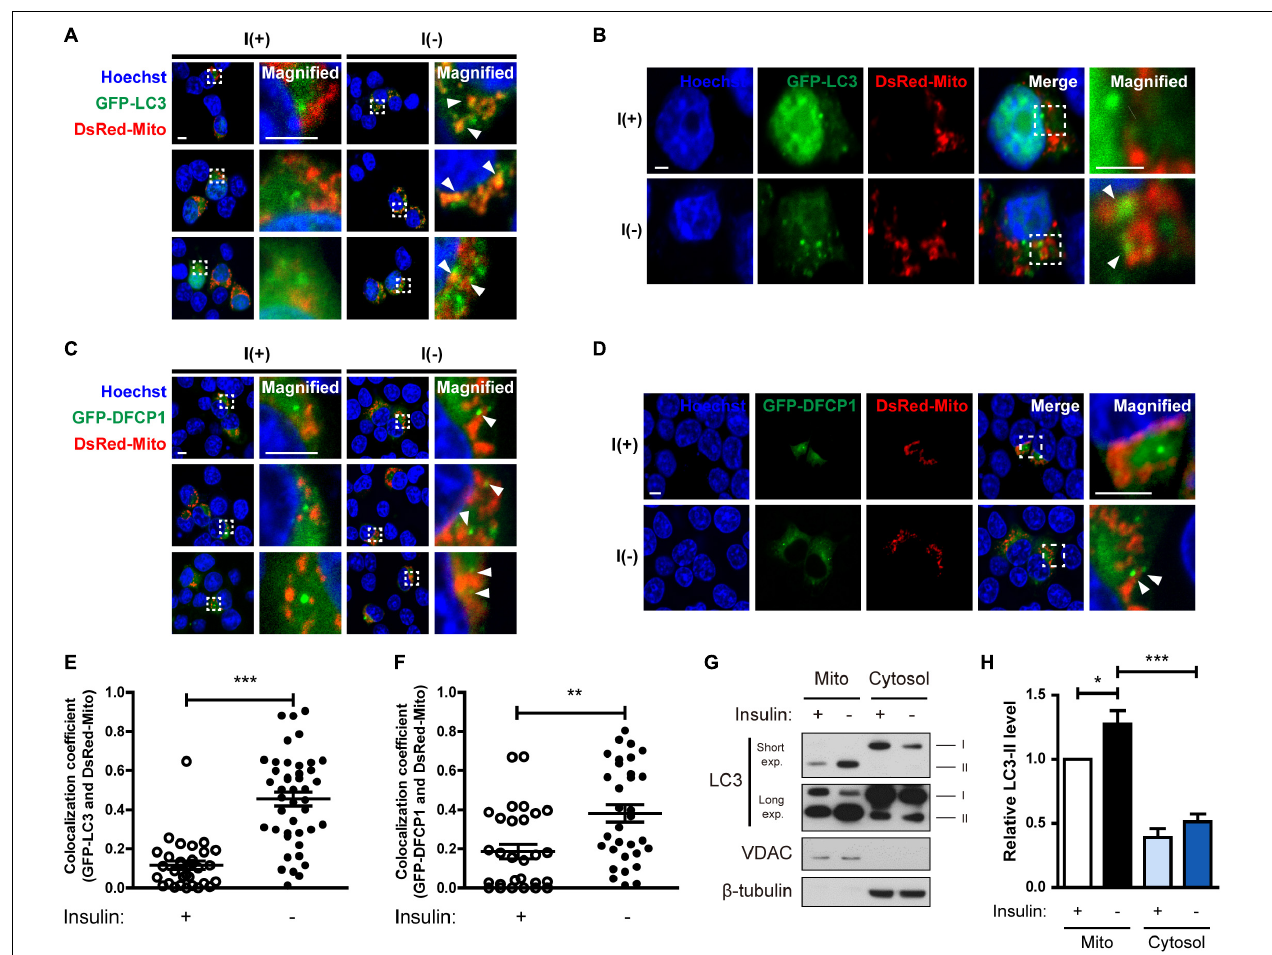
FIGURE 3 | Insulin-deprived HCN cells undergo excessive mitophagy. (A,B) Colocalization of GFP-LC3 and DsRed-Mito (arrowheads) after insulin withdrawal for 24 h. Scale bars, 5 µ m for (A) , 2 µ m for (B) . (C,D) Immunofluorescence of GFP-DFCP1 and DsRed-Mito after insulin withdrawal for 24 h. Arrowheads indicate colocalization of GFP-DFCP1 and DsRed-Mito. Scale bars, 5 µ m for (C) , 2 µ m for (D) . (E) Quantification of colocalization of LC3 and mitochondria ( n = 31 cells for I( + ), 42 cells for I(-) from 3 independent experiments). (F) Quantification of colocalization of DFCP1 and mitochondria ( n = 30 cells for I( + ), 33 cells for I(-) from 3 independent experiments). (G) Western blotting analysis of mitochondrial translocation of LC3 after insulin withdrawal for 24 h. Mito, mitochondrial fraction; cytosol, cytosolic fraction. The blots shown are representative of four experiments with similar results. (H) Quantification of LC3-II levels ( n = 4) from (G) . ∗ p < 0.05, ∗∗ p < 0.01, ∗∗∗ p < 0.001.